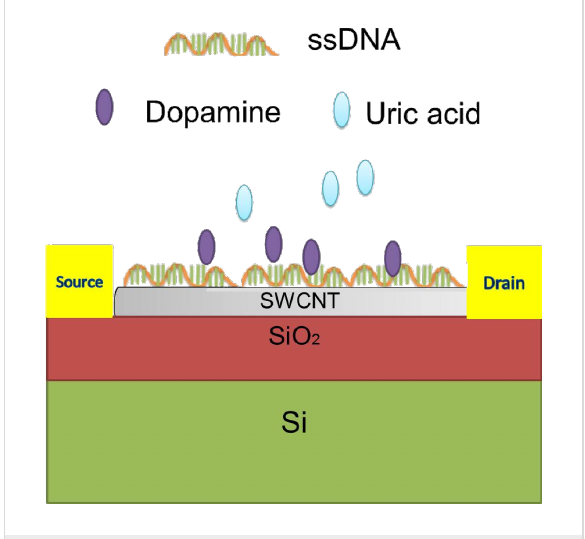
Figure 2: Schematic diagram of ssDNA-decorated SWCNT-based FET for DA detection.